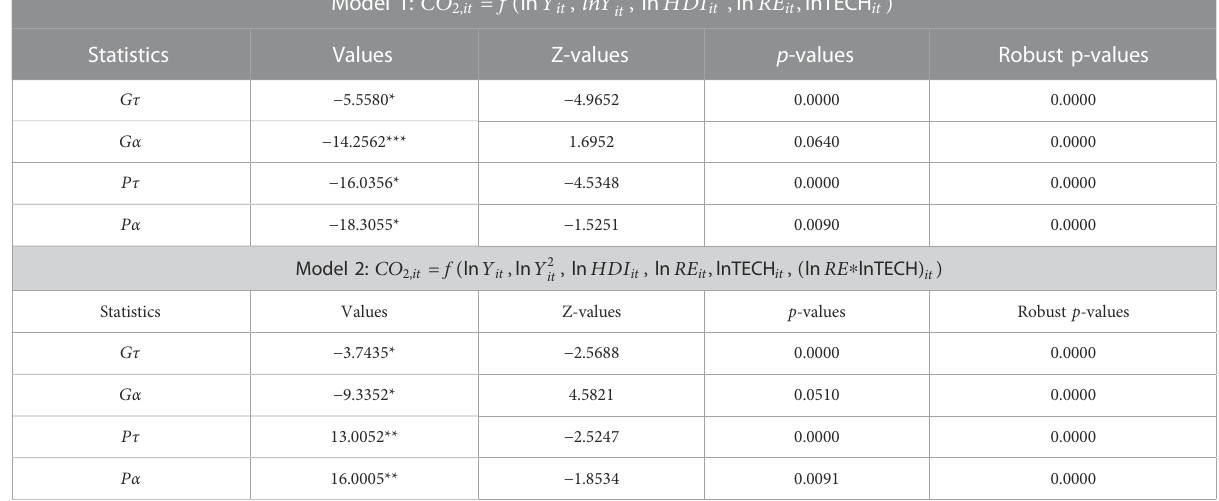
TABLE 6 Cointegration test results.